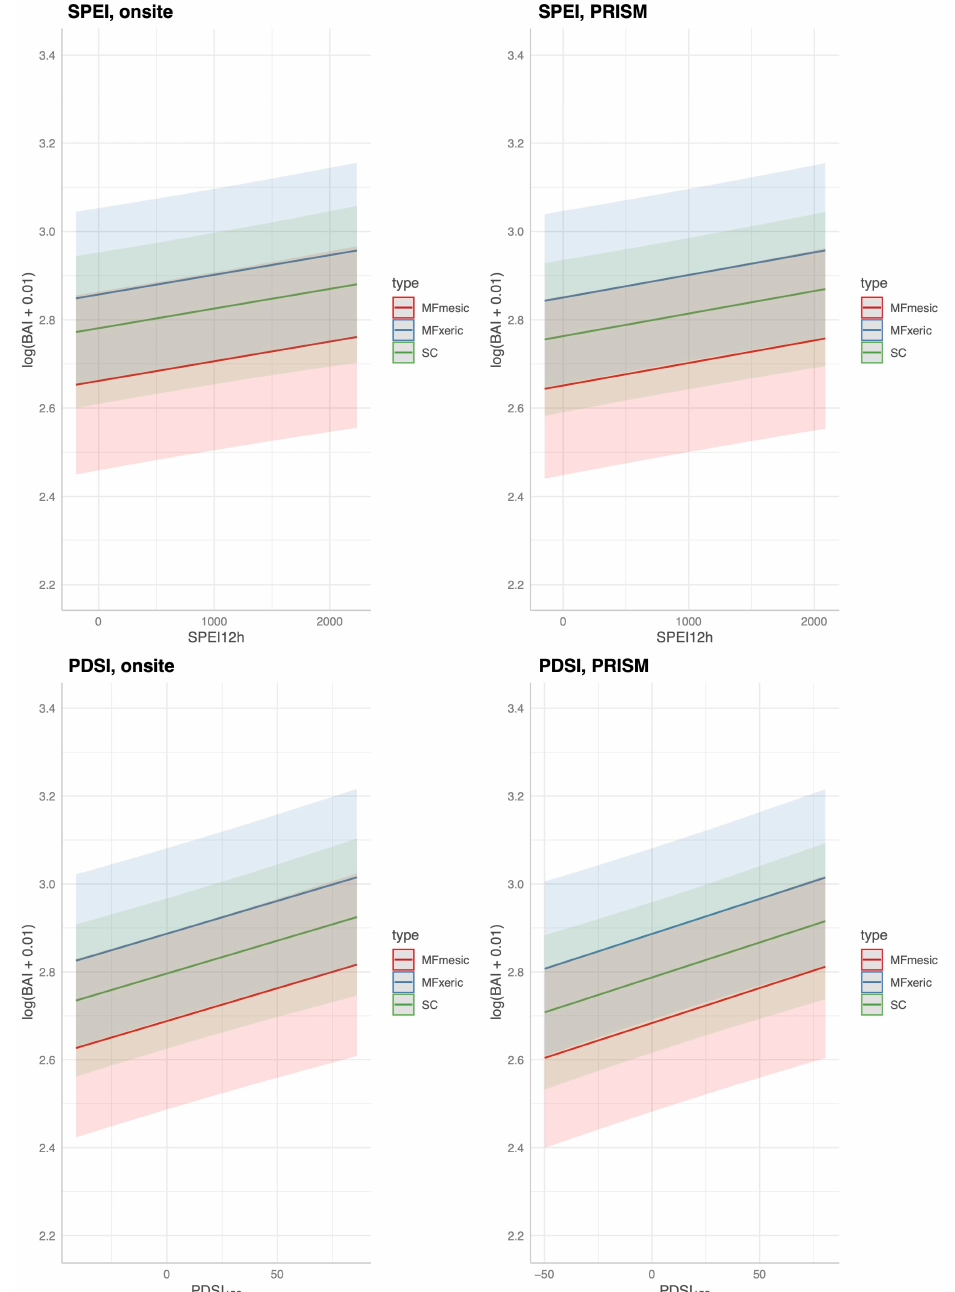
Figure 7. Predicted log(BAI + 0.01) as a function of on-site and PRISM parameterizations of SPEI and PDSI 152 . Other variables included in the model (Equation (6)) are fixed at their mean values (tree crown vigor, bole growth vigor, and tree competition).